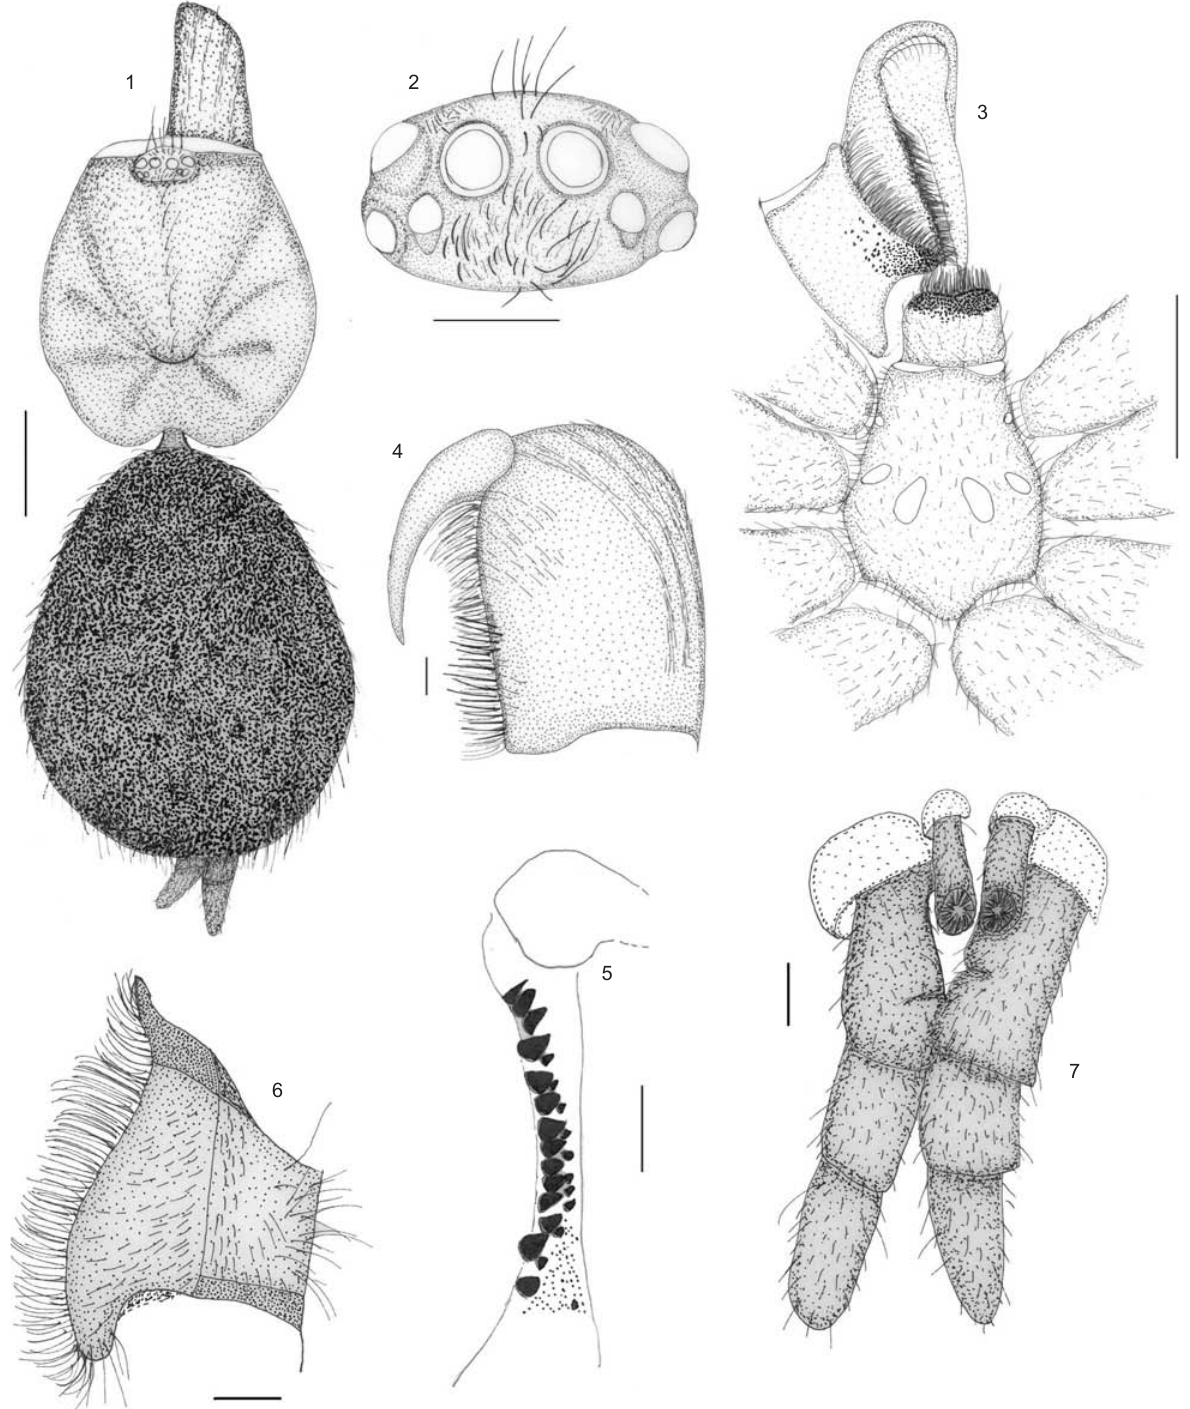
Figures 1–7. 1 - Dorsal view of spider, scale 0.5mm; 2 - Eye, scale 1mm; 3 - Sternum, maxillae, labium, scale 0.5mm; 4 - Chelicerae, scale 1mm; 5 - Chelicerae teeth, scale 1mm; 6 - Maxillae, scale 1mm; 7 - Spinnerets, scale